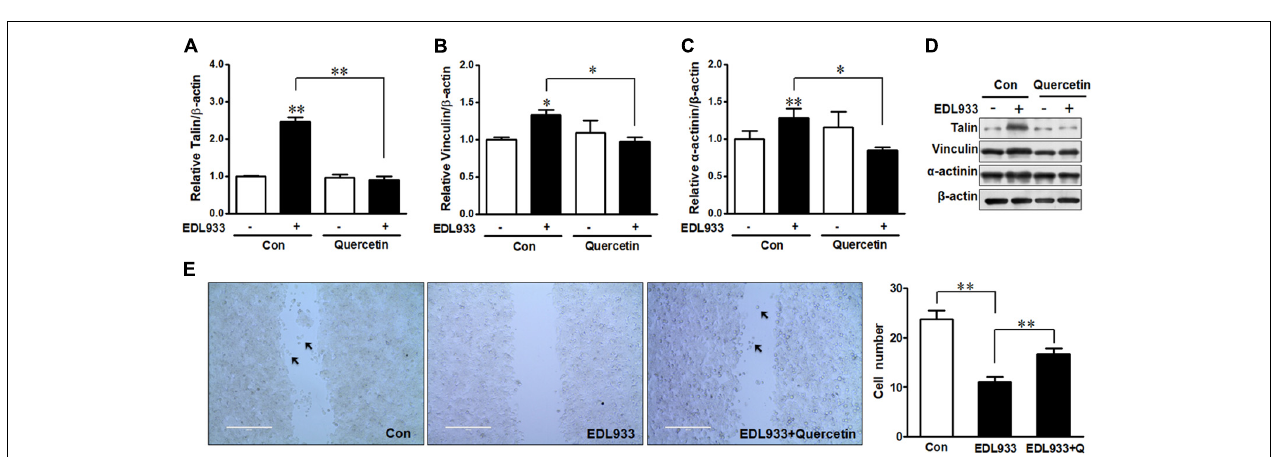
FIGURE 8 | Focal adhesions were reduced by quercetin upon E. coli O157:H7 infection. (A–D) Immunoblotting analysis of talin, vinculin, and α -actinin. (E) Migration of Caco-2 cells pretreated with or without quercetin followed by infection with EDL933 strain for 4 h. Con, cells without infection; EDL933, cells infected with EDL933 strain. EDL933 + Quercetin: cells pretreated with quercetin then infected with EDL933 strain. Means ± SEM; n = 4. ∗∗ P ≤ 0.01; ∗ P ≤